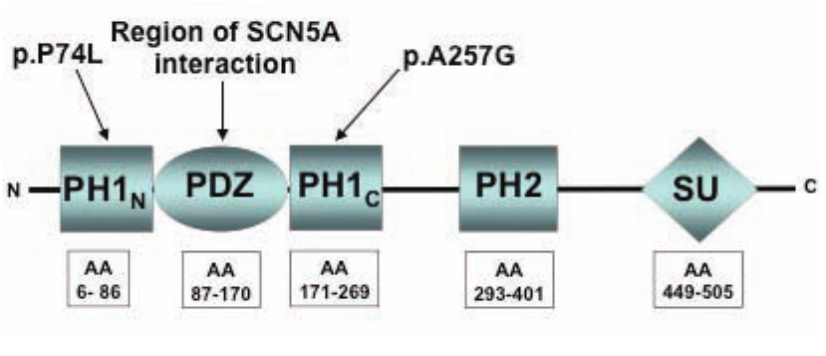
Figure 2. Localization of SNTA1 variants. Illustrated is the linear topology for SNTA1 with variant